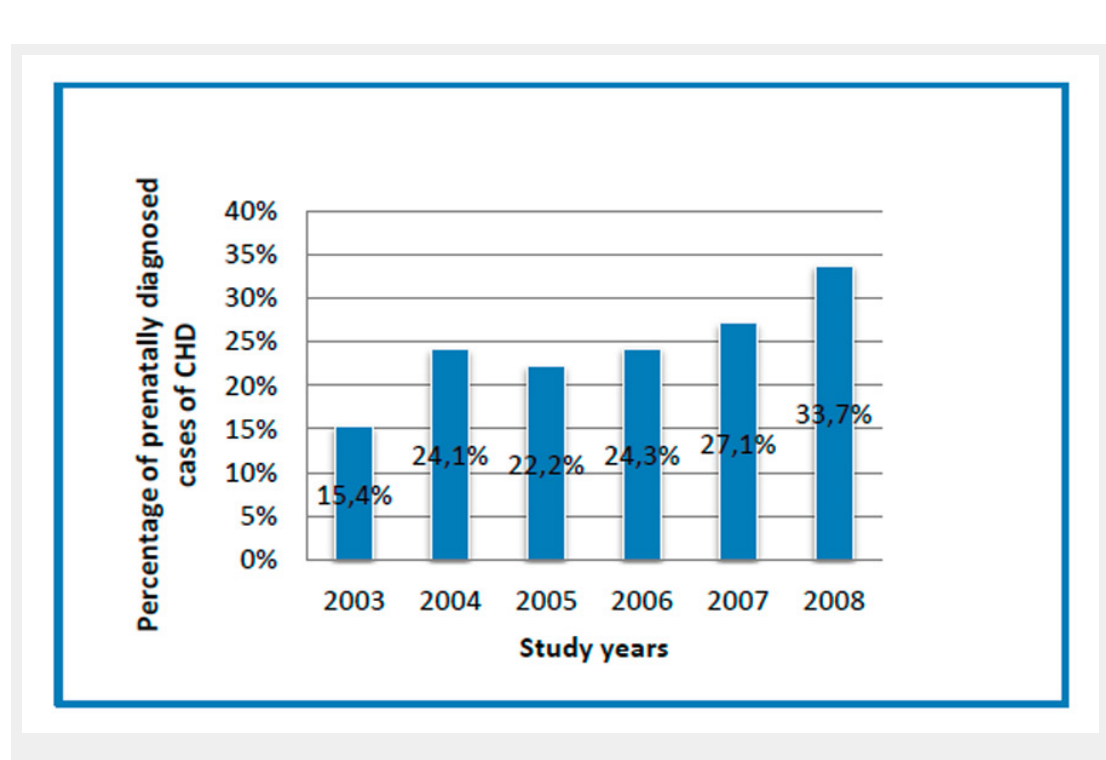
The percentage of prenatally diagnosed cases of CHD by year, demonstrating a significant increase between 2003 and 2008 ( p =